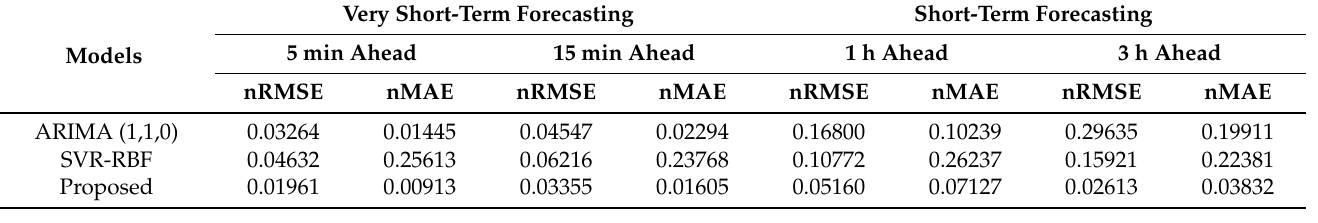
Table 8. Forecasting performance comparison with other models.